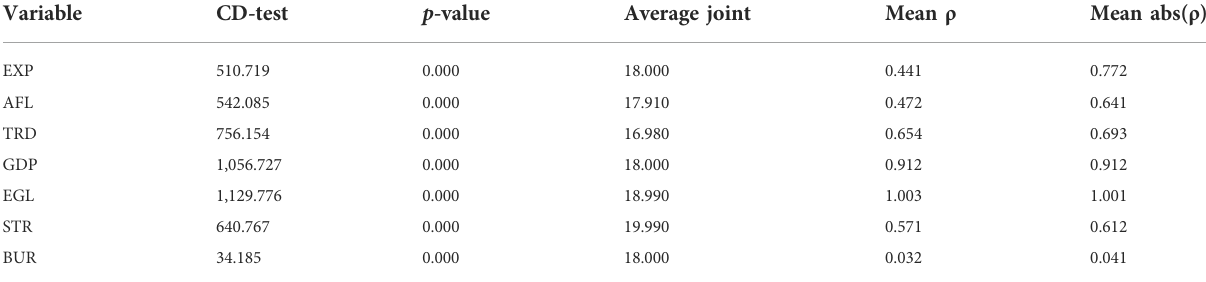
TABLE 2 Cross-sectional dependence test. Variable